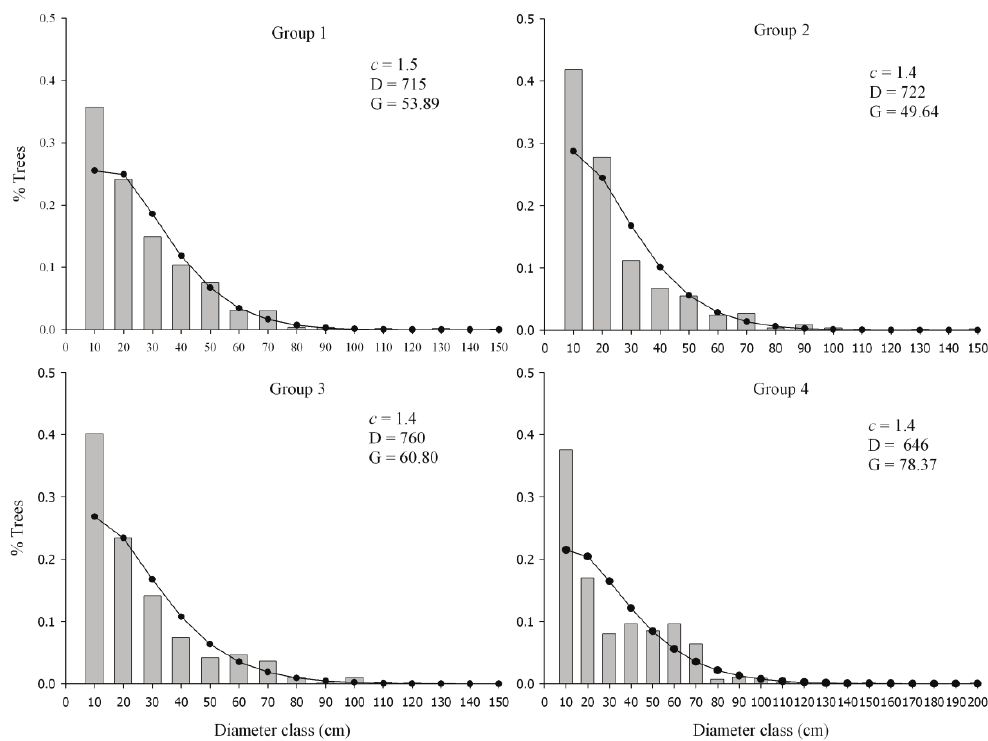
Figure 4. Diameter structure by forest group including all tree species. Weibull function line indicates the adjusted size distribution. c = Weibull shape parameter, D = mean density (trees per ha), G = mean basal area (m 2 per